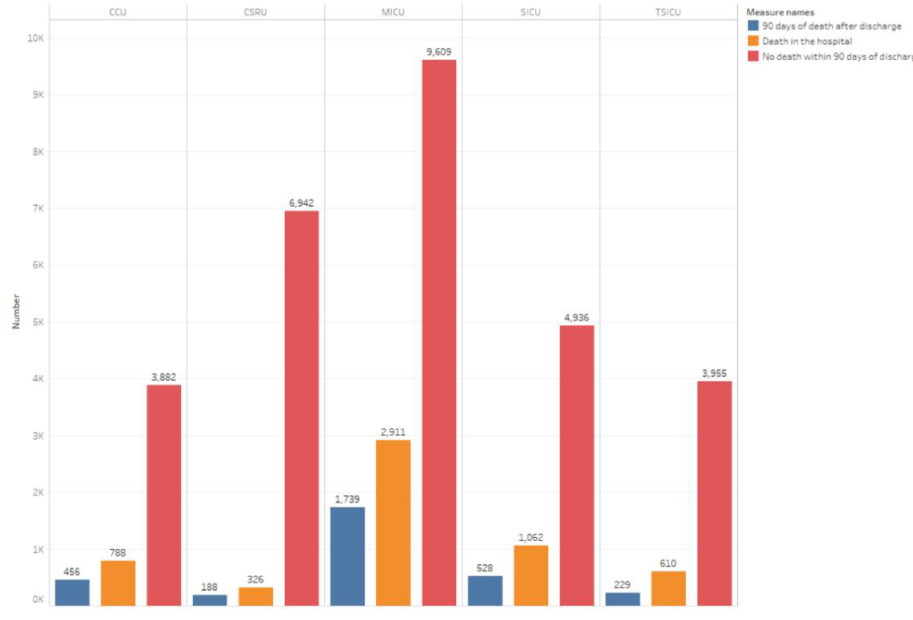
Fig 1. ICU distribution of all patients admitted to the ICU (Total number of patients is 38161).